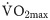
Physical fitness indices and percent change in maximum number of repetitions (n = 25).A, Relationship between maximal oxygen uptake (V˙O2max) and percent change in maximum number of repetitions between hyperoxic conditions and normoxic conditions (change ratio). The change ratio was calculated as follows: (HOXmax − NOXmax) / NOXmax × 100, where HOXmax and NOXmax indicate the maximum number of repetitions under hyperoxic and normoxic conditions, respectively. B, Relationship between muscular endurance and percent change in maximum number of repetitions. Maximum number of repetitions measured under normoxic conditions was used as an index of muscular endurance. The 95% confidence intervals (CI) for the correlation coefficient included 0 (95% CI = −0.003–0.565), indicating the absence of a significant correlation. C, Relationship between maximal muscle strength and percent change in maximum number of repetitions.